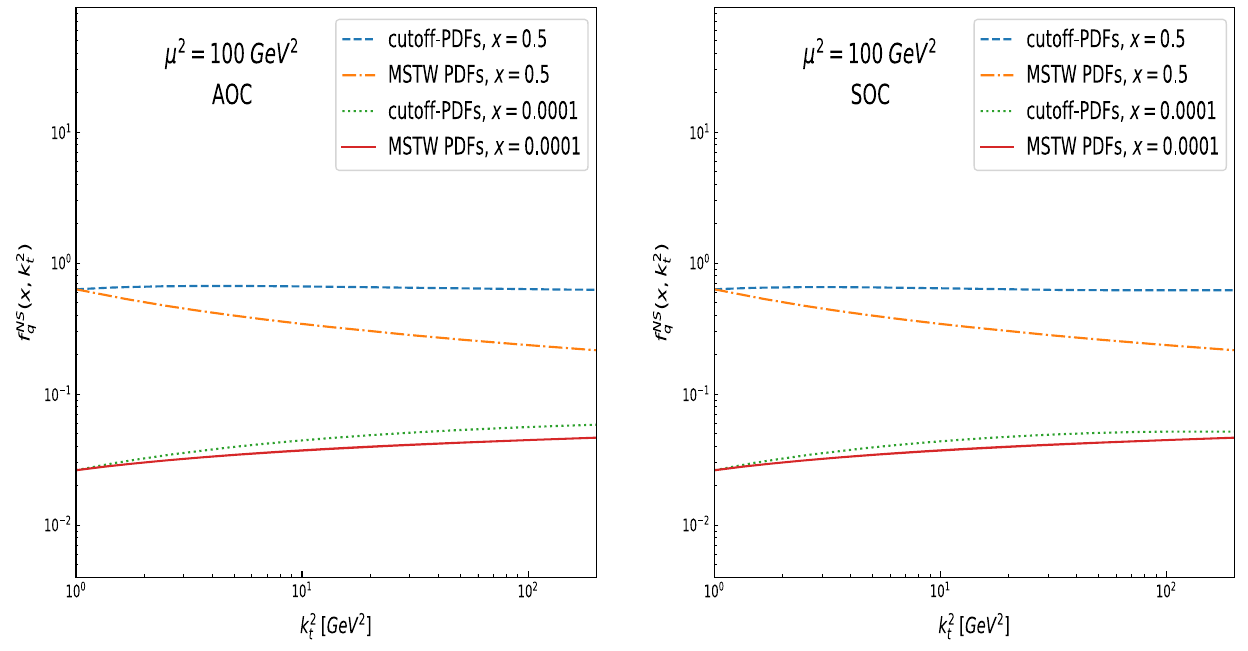
Fig. 3 The left (right) panel shows the comparison of the non-singlet quark distributions of AOC (SOC) cutoff-dependent PDF with the MSTW one at μ 2 = 100 GeV 2